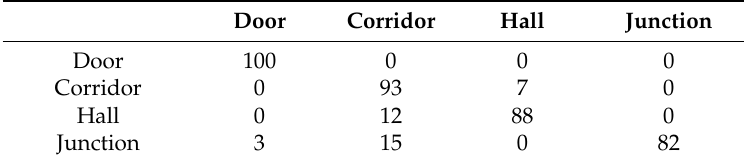
Table 4. Confusion matrix of situation awareness